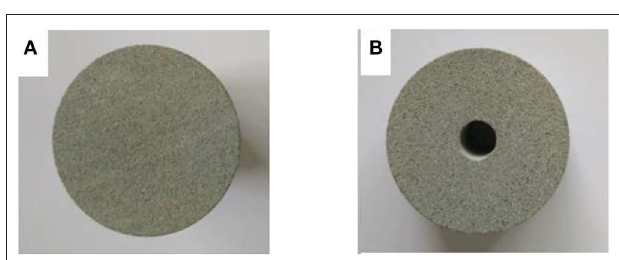
FIGURE 2 | Specimen: (A) Intact specimen (Type A), (B) B Hollow specimen (Type